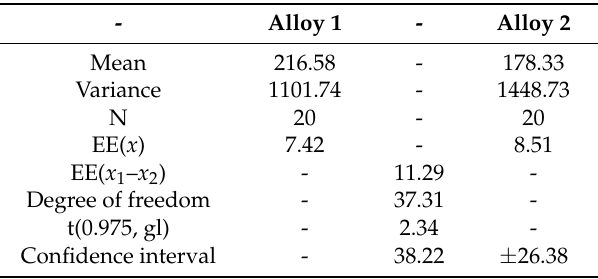
Table 5. Contrast of hypothesis for alloy 1 and alloy